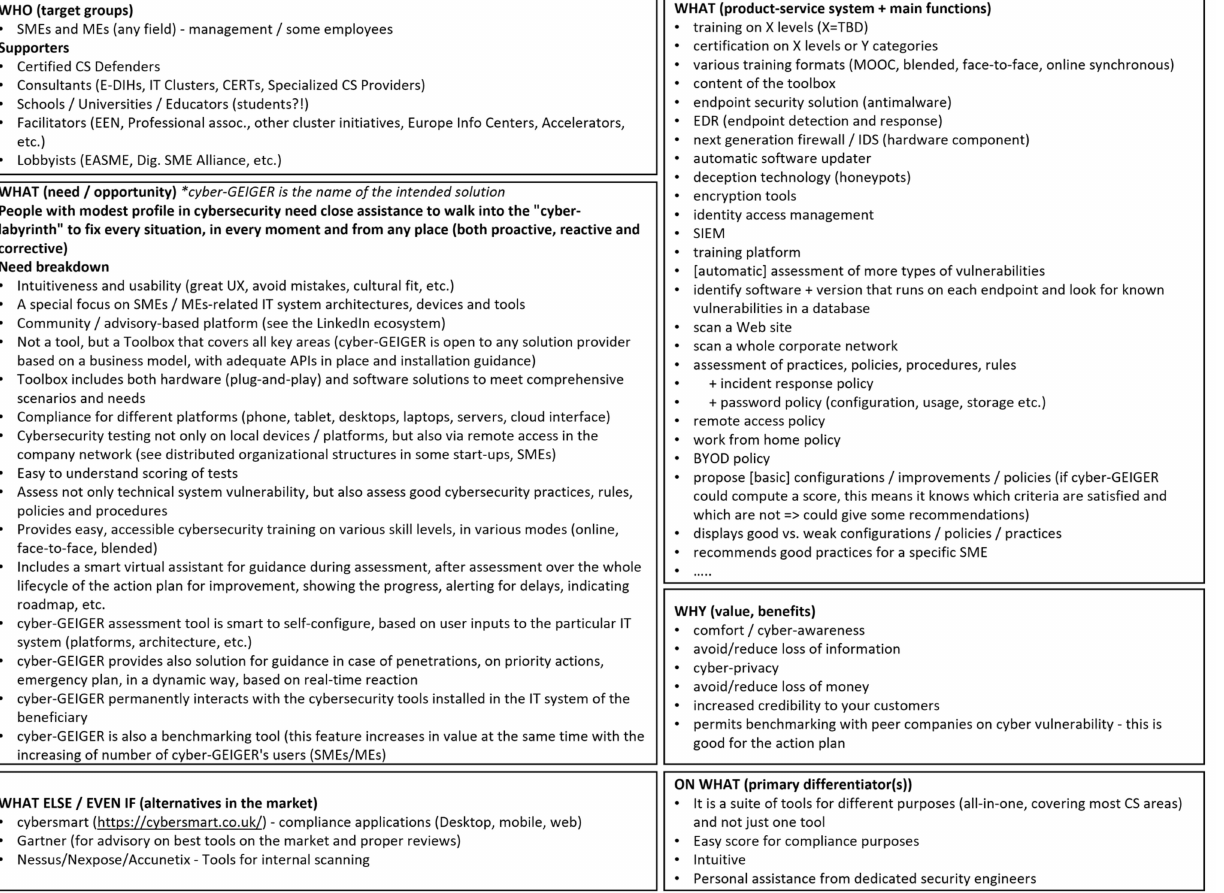
Figure 3. Initial vision for the disruptive solution (called here for convenience